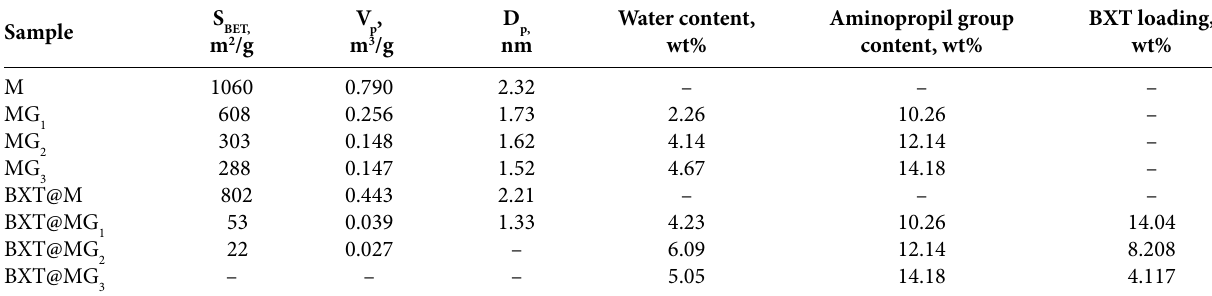
samples and BXT@MG x